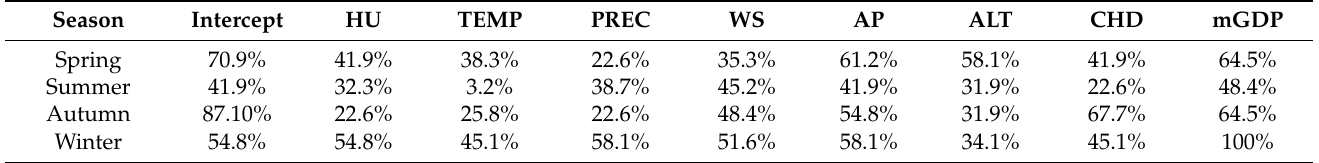
Table 6. The t-test pass rate of the potential risk factors in the four